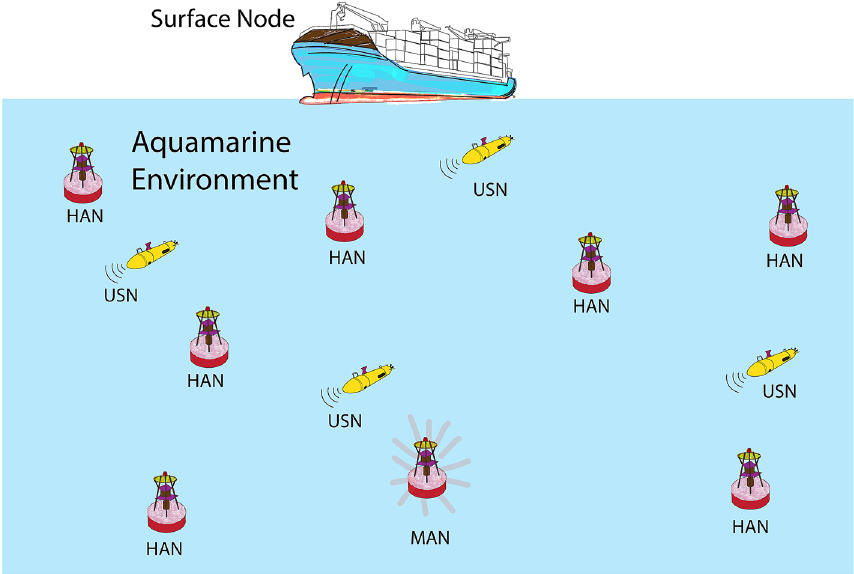
Figure 1. An underwater wireless sensor network scenario. HAN, Healthy Anchor Nodes; MAN, Malicious Anchor Node; USN, Underwater Sensor Node.